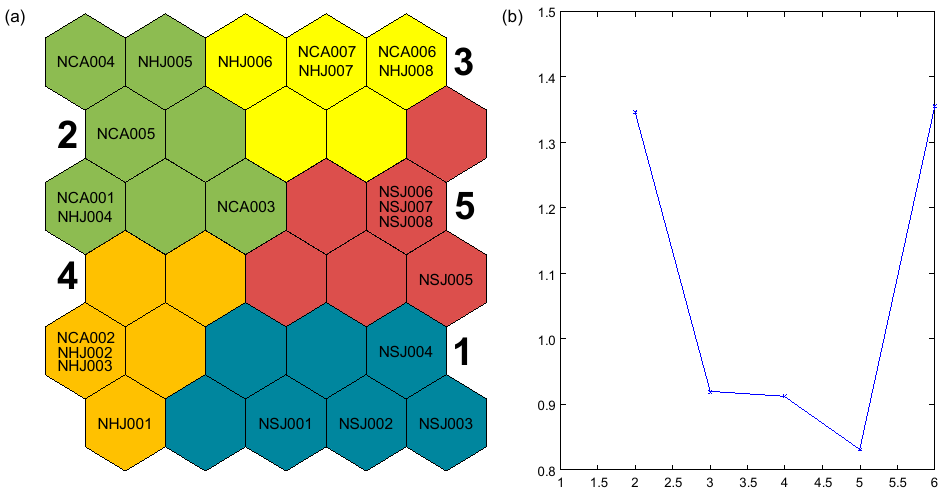
Figure 6. ( a ) Distribution and classification of sampling sites in the self-organizing map based on the abundance of benthic macroinvertebrates, ( b ) K-means cluster with Davies-Bouldin index. Numbers 1 to 5 indicate cluster defined by self-organizing map.